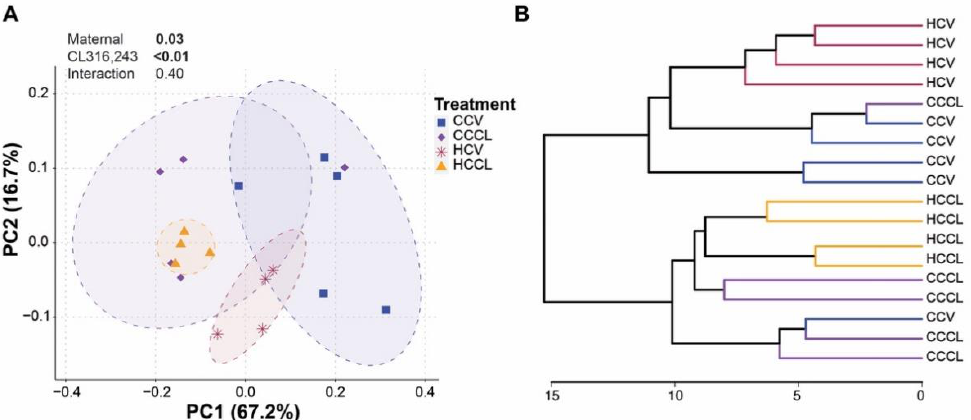
Figure 2. Murine gut bacterial community composition driven by maternal diet and CL316,243 challenge. ( A ) Genus-level principal coordinate analysis plot based on Bray–Curtis dissimilarities. Axes show the first two principal components and their corresponding percentage of variance explained. Ellipses define the 95% confidence level. Two-way PERMANOVA was used to determine the main effects of maternal diet, CL316,243 challenge and their interaction (statistically significant p -values are bolded). ( B ) Hierarchical dendrogram based on Ward’s method displaying clustering by treatment. CCV = offspring of control diet-fed dams treated with vehicle (n = 5); CCCL = offspring of control diet-fed dams treated with CL316,243 (n = 5); HCV = offspring of high-fat diet-fed dams treated with vehicle (n = 4); HCCL = offspring of high-fat diet-fed dams treated with CL316,243 (n = 4).